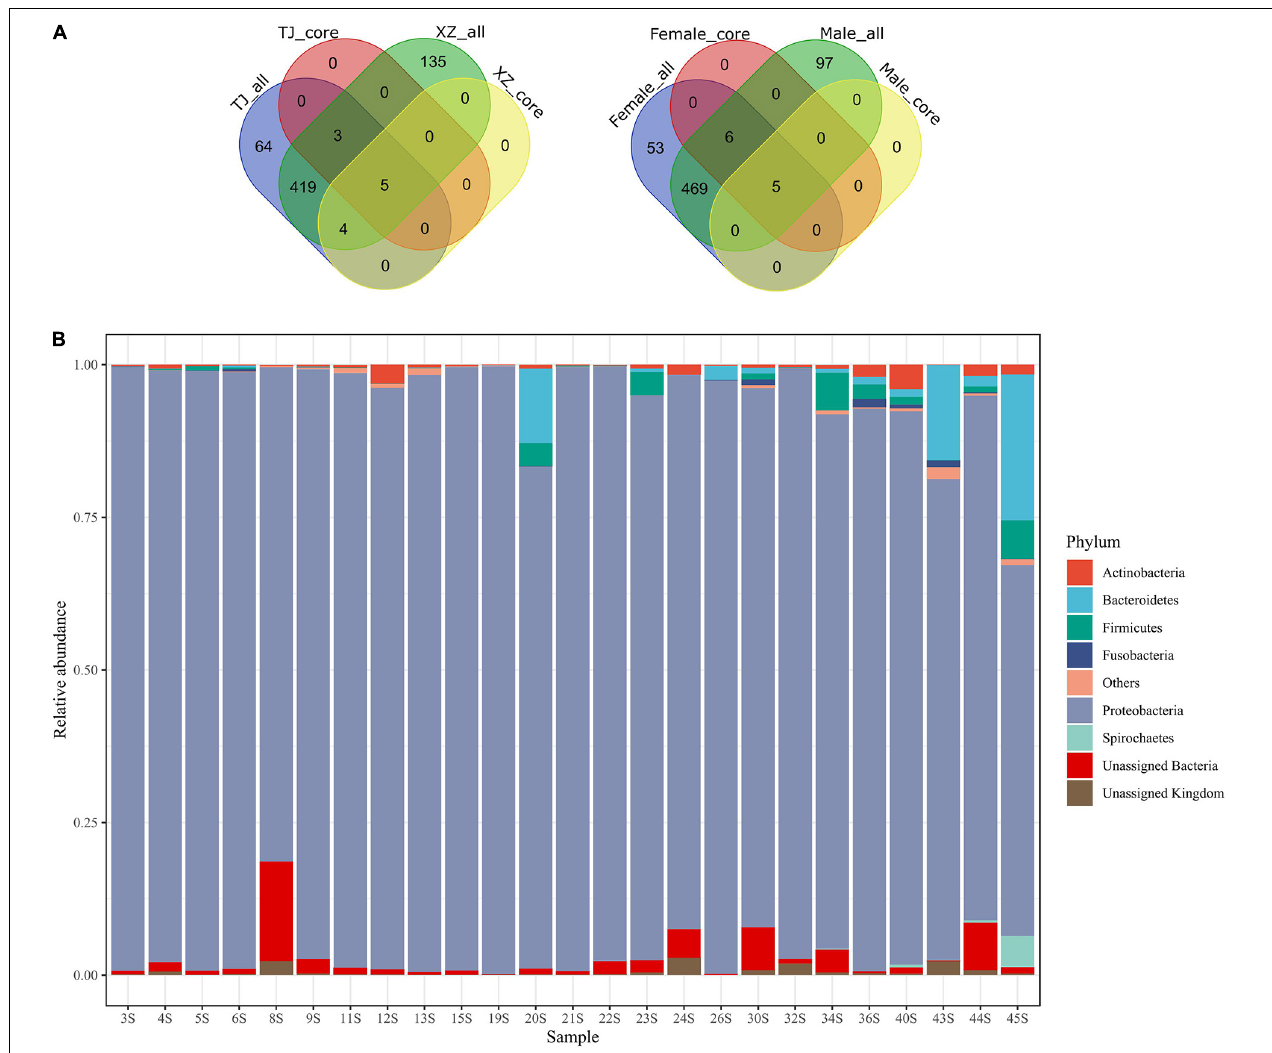
FIGURE 1 | Distribution of OTUs between groups (A) and relative abundance of phyla in 25 gut microbiota samples (B) . In the Venn diagrams, each group (i.e., location or sex) with an “all” or “core” suffix represents total OTUs or core OTUs (i.e., 100% individual coverage) of a given group, respectively. The taxa with average relative abundance among individuals < 0.001 were grouped as